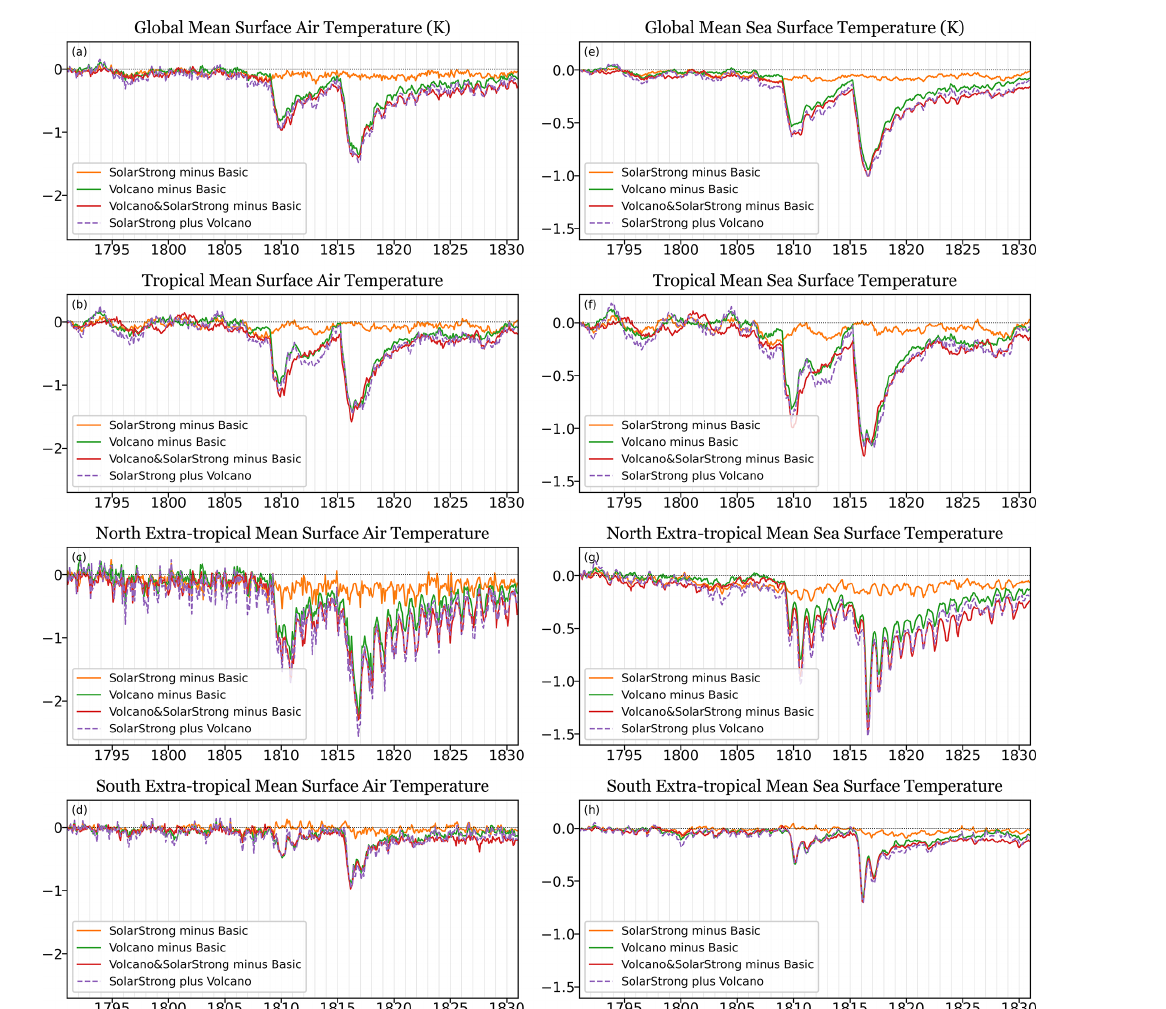
Figure 6. (a) Ensemble mean global mean SAT (K) anomalies of the SolarStrong (orange), Volcano (green), and Volcano&SolarStrong (red) minus the Basic experiment. The purple dashed line is the sum of SolarStrong and Volcano (minus Basic) experiment. The gray vertical lines are the January for each year. (b) Tropical mean, (c) northern extratropical mean, and (d) southern extratropical mean. (e) – (h) are for SST